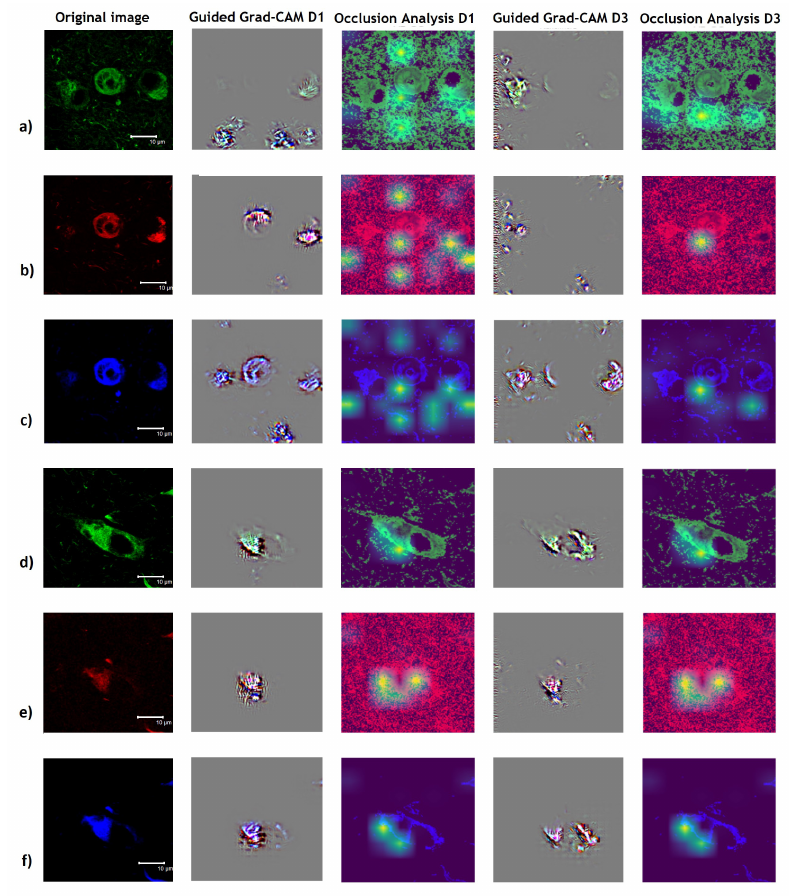
Figure 11. Model interpretability studies using XAI techniques for PSP and AD classification in the hippocampus region of patients with tauopathies. ( a ) Guided Grad-CAM analysis (second and fourth column) for AD classification of green channel highlights NFT in the southern (for D1) and western (for D3) periphery of the image. Occlusion Analysis (third and fifth column) highlight the southern and northern periphery (for D1) and only the southern periphery (for D3) of the image. ( b ) Guided Grad-CAM analysis (second and fourth column) for AD classification of red channel highlights neurofibrillary tangle at the center (for D1) and periphery (for D3) of the image. Occlusion Analysis (third and fifth column) highlights the southern and northern periphery as well as the center (for D1) and only the center of the image (for D3). ( c ) Guided Grad-CAM analysis (second and fourth column) for AD classification of blue channel highlights neurofibrillary tangle at the center and southern periphery (for D1) and periphery (for D3). Occlusion Analysis (third and fifth column) highlight the southern and northern periphery as well as the center (for D1) and only the center and southern periphery (for D3). ( d – f ) Guided Grad-CAM analysis (second and fourth column) for PSP classification highlights mainly over all the originally colored middle portion of the image (for D1 and D3). Occlusion Analysis (third and fifth column) highlights the center of the image (for D1 and D3). In the green channel ( a , d ) immunoreactivity of the AT8 antibody directed against the biomarker for dual phosphorylation at serine 202 and threonine 305 of the Tau polypeptide is observed ( a , d ). The red channel ( b , e ) shows staining with Thiazine red dye for fibrillar forms of pathological Tau aggregates. The blue channel ( c , f ) shows immunoreactivity of the pS396 antibody directed against the biomarker for phosphorylation at amino acid serine 396 of Tau